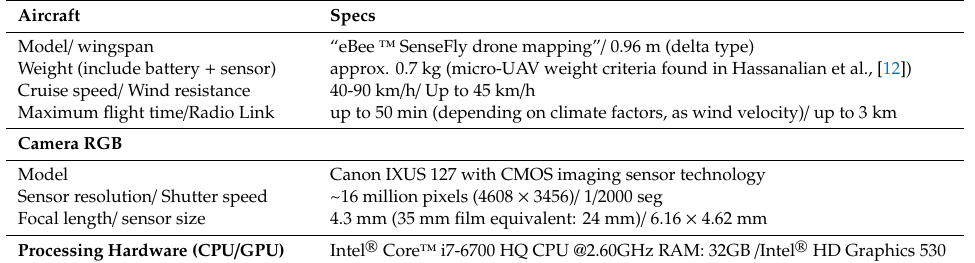
Table A1. Technical specs of the micro-UAV fixed-wing system and hardware for image processing